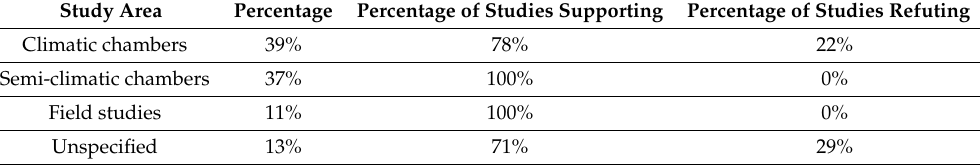
Table 2. Variation in typologies of experimental